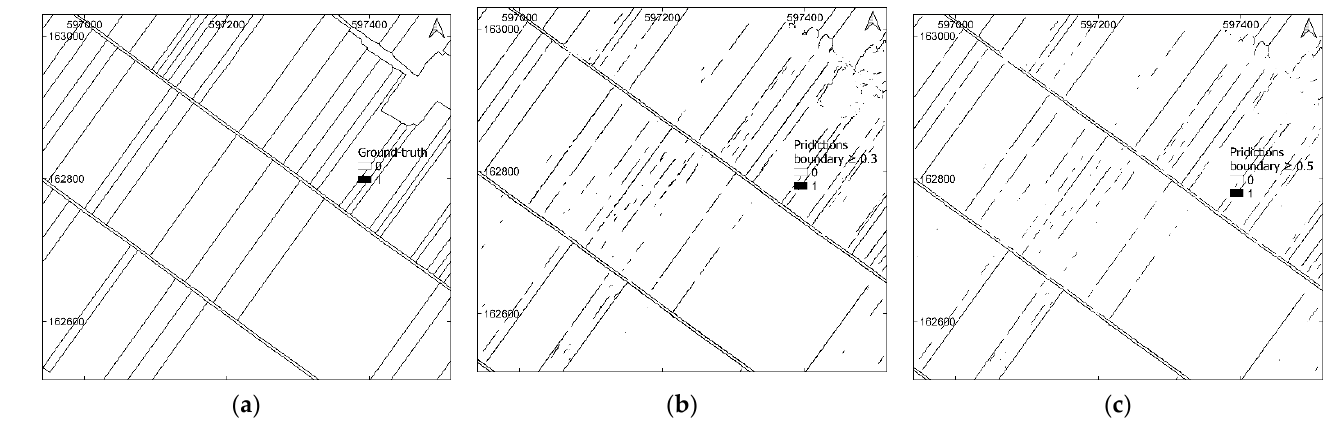
Figure 8. ( a ) Ground truth image for Odranci, Slovenia. ( b , c ) Reclassified boundary maps obtained with customised CNN: ( b ) with threshold 0.3, and ( c ) with threshold 0.5.